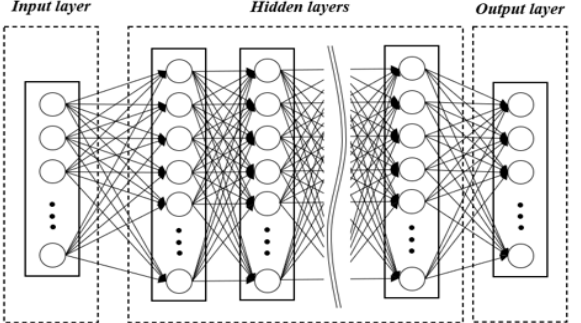
Figure 4. Schematic of the structure of the artificial neural network (ANN).